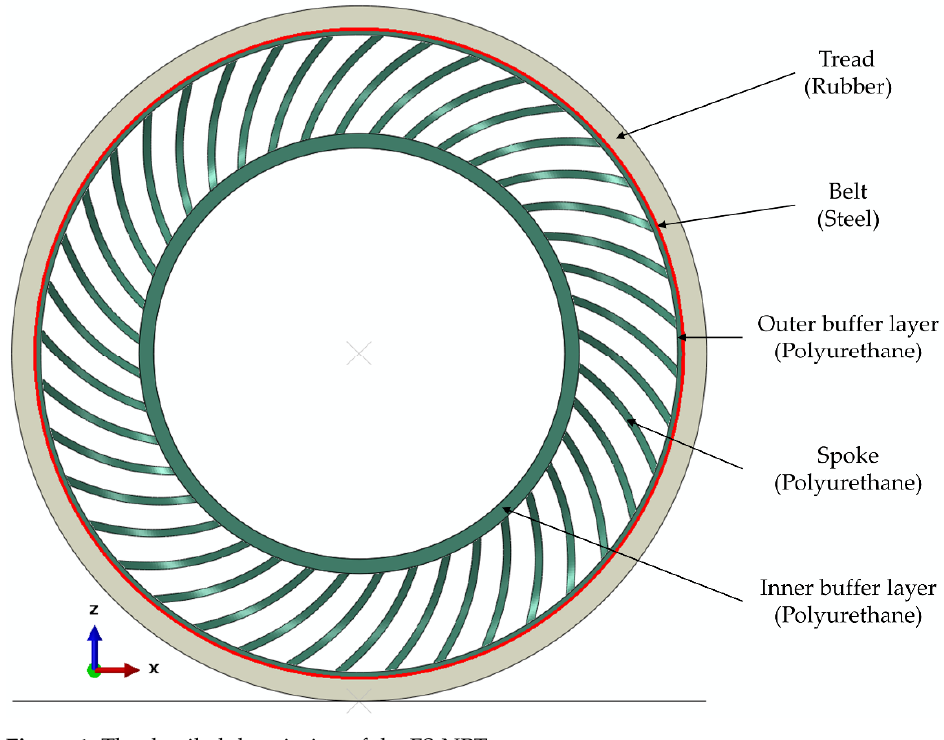
Figure 1. The detailed description of the FS-NPT.